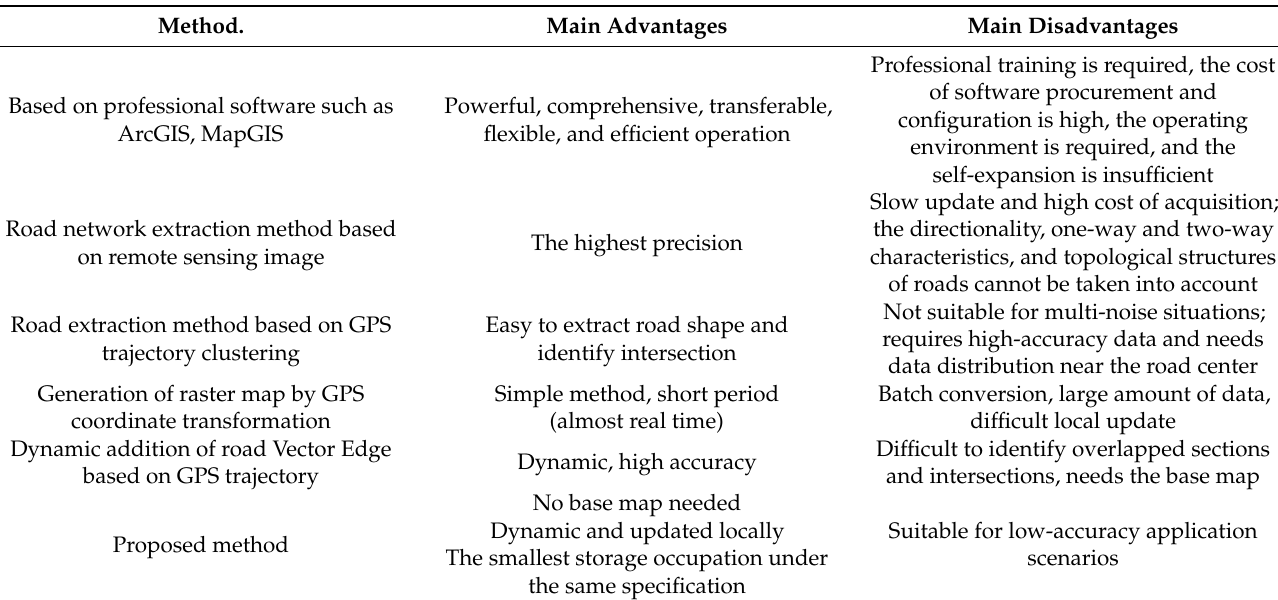
Table 2. Comparison of different raster map construction